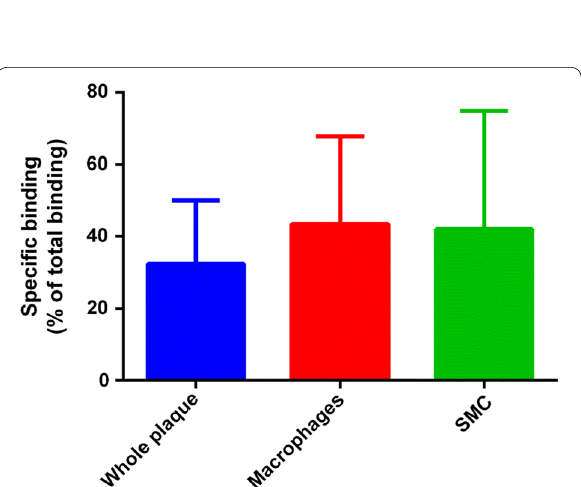
Fig. 4 Quantification of [ 18 F]‑PBR06 specific binding according to various areas of atheromatous plaque (whole plaque, macrophages, and smooth muscle compartment (SMC)) of all eight